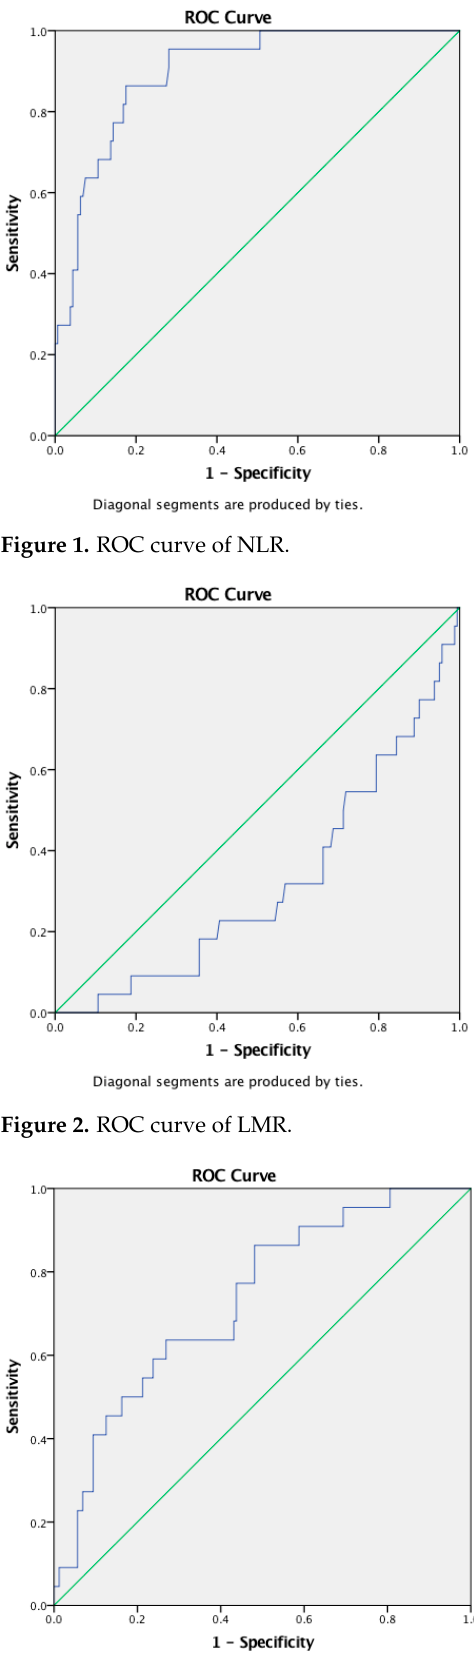
Figure 3. ROC curve of PLR.